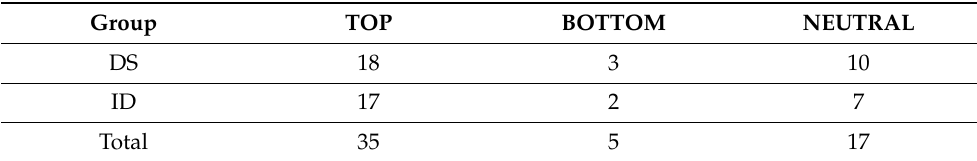
Table 4. Down syndrome and mixed ID participants classified by types of questions most often answered correctly.